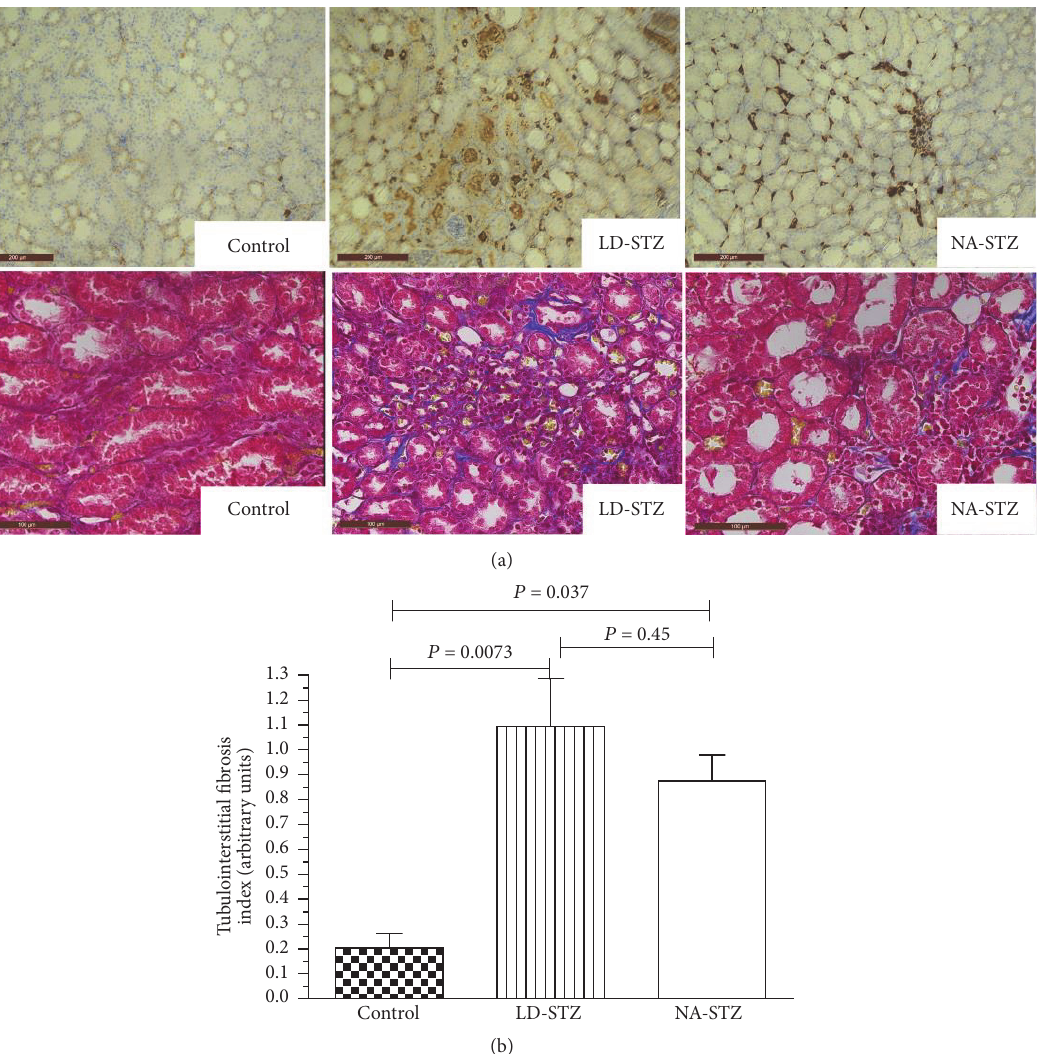
Figure 12: Tubulointerstitial lesions in experimental groups at week 30. (a) Representative immunostaining with anti-collagen type IV antibodies (upper row, original magnification × 200) and Masson’s trichrome staining (lower row, original magnification × 320) of kidney sections from control nondiabetic group, low-dose streptozotocin-injected group, and nicotinamide-streptozotocin-induced diabetic group. Kidney tissues from both diabetic groups demonstrate tubulointerstitial lesions with tubular dilation and partial tubular atrophy compared to control nondiabetic rats and are characterized by interstitial inflammatory infiltration (indicated by white arrows on Figure 11(a)). Marked increase expression of collagen type IV is seen in tubular basement membrane, vascular walls, and interstitial areas in both diabetic groups. (b) Graphic representation of semiquantitative indices of tubulointerstitial fibrosis in control and two diabetic groups. Mean values and standard deviations are